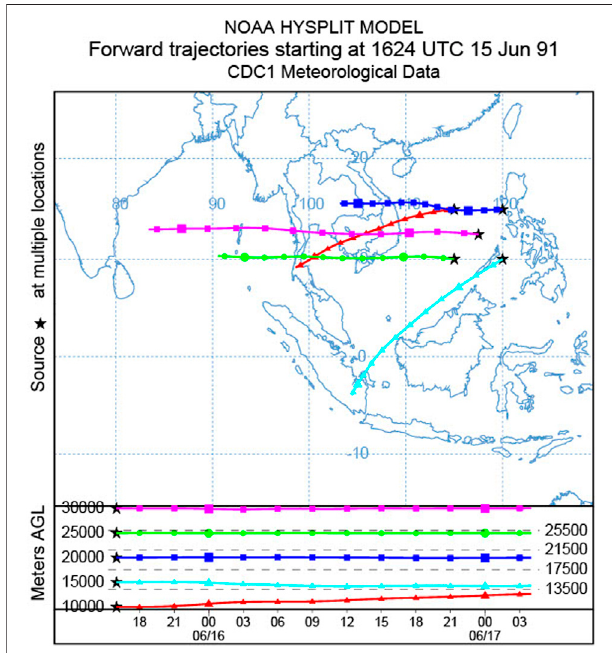
FIGURE 6 | Trajectories of particles starting from different heights indicating the wind directions of different evaluations. The trajectories are chosen to start at points that were on the perimeter of the umbrella cloud in x , y , and z , and in its center, right before it became affected by the wind to giveanideaofthemaximumpossiblespread ofthetrajectoriesfromthatinitial